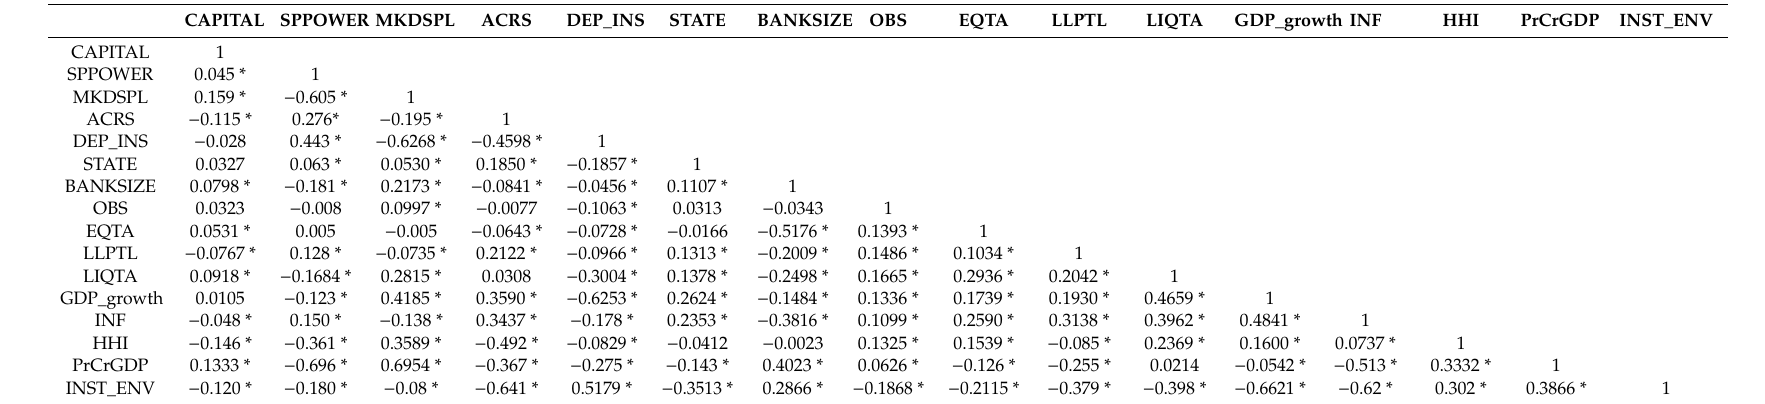
Table A2. Pairwise correlation between independent variables in the